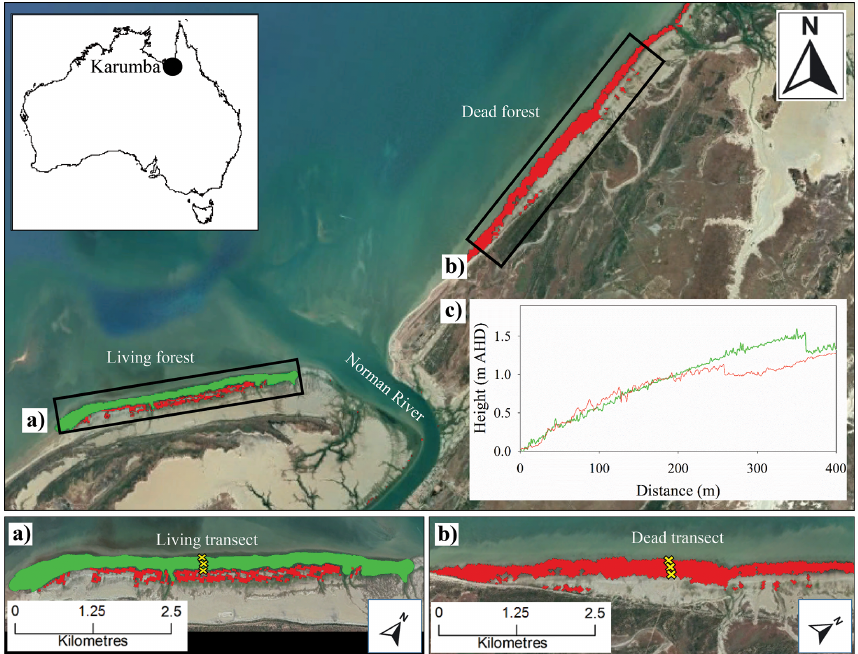
Figure 1. Study sites of (a) the living mangrove area (green) and (b) the dead mangrove area (red) near the mouth of the Norman River, Karumba, QLD. Note that the yellow crosses represent transects through the upper, middle and lower study sites. (c) The elevation above the Australian Height Datum (AHD) from a lidar digital elevation model (DEM) was measured from the seaward mangrove edge in 2017, from the same transects that samples were collected from in 2016, through the living (green line) and dead (red line) mangrove areas (data available from http://wiki.auscover.net.au/wiki/Mangroves, last access: August 2019). The satellite images were sourced from © Google Earth (2019) and the Queensland Government